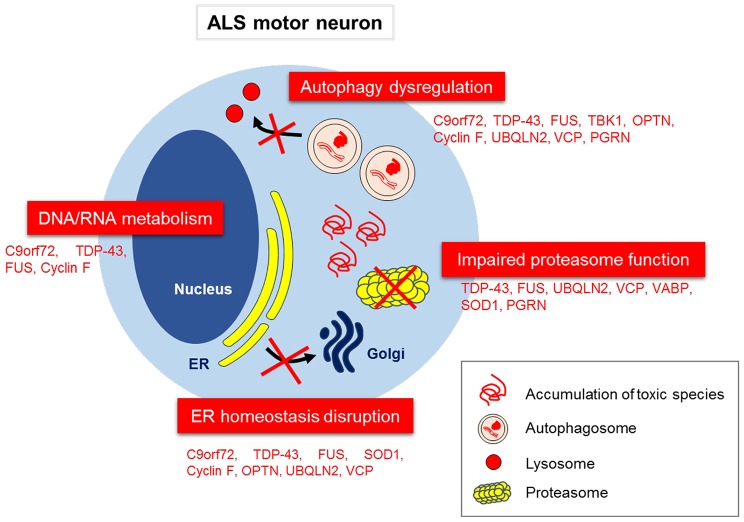
Disruption to proteostasis mechanisms in ALS/FTD. Aberrant subcellular localization of misfolded proteins, and their associated effects on the proteostasis network, including proteasome dysfunction, autophagy dysregulation, ER to Golgi transport inhibition and ER stress. Aberrant DNA/RNA metabolism is also implicated as an important pathophysiological mechanism in ALS.